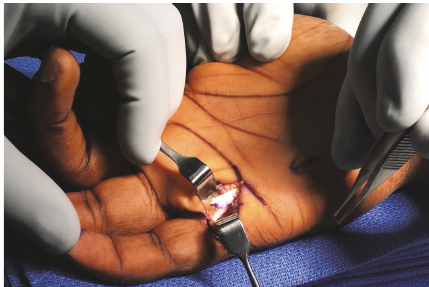
Figure 1: Intraoperatively, the triggering was found to be attributa- ble to a partial attritional rupture of the small finger flexor digitorum profundus tendon.